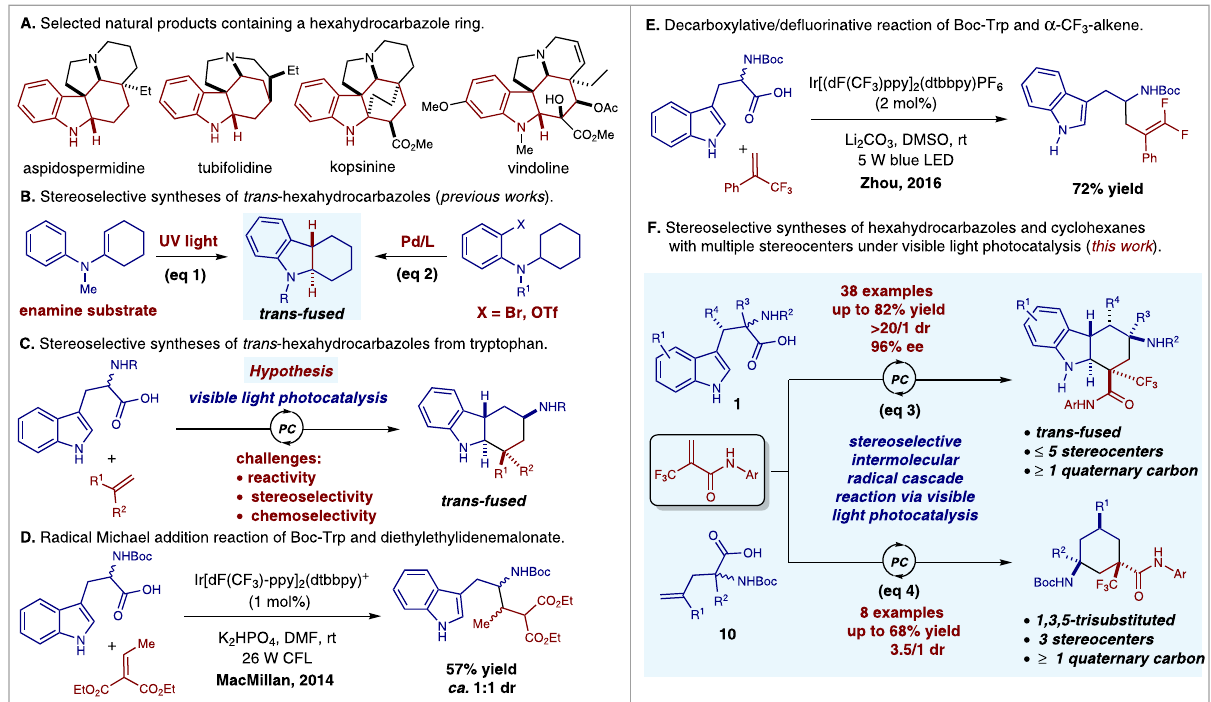
Fig. 1 Syntheses of trans -fused hexahydrocarbazoles and 1,3,5-trisubstituted cyclohexanes through stereoselective intermolecular radical cascade reaction under visible light photocatalysis. A Natural products containing a hexahydrocarbazole ring. B Previous works. C Hypothesis. D Reaction of Boc- Trp and diethylethylidenemalonate. E Reaction of Boc-Trp and ɑ -CF 3 -alkene. F This work. PC photocatalyst, Trp